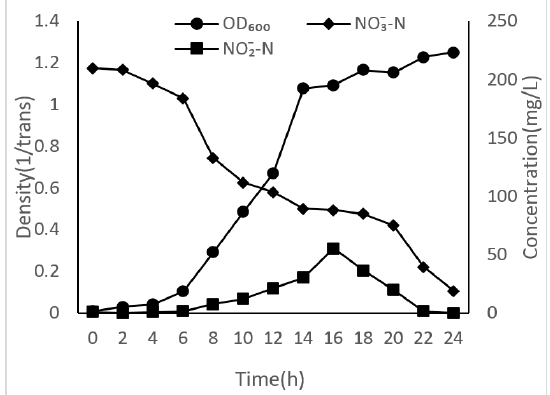
Figure 3. Growth curve of synthetic microbial community with KNO 3 as the sole nitrogen source.